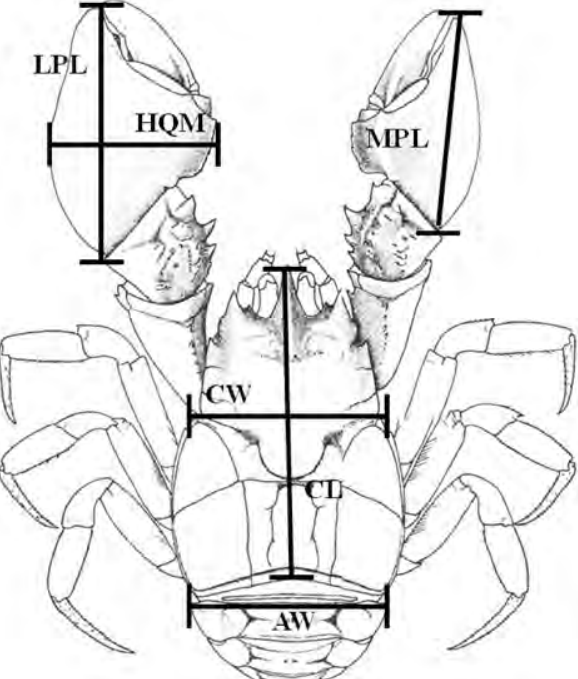
Figure 1. Aegla georginae body dimensions. CL, cephalothorax length; CW, cephalothorax width; AW: second abdominal somite width; MPL, minor propodus lenght; LPL, larger propodus length; HMQ: height of the major chela. Adapted from S antoS et al. (2013).